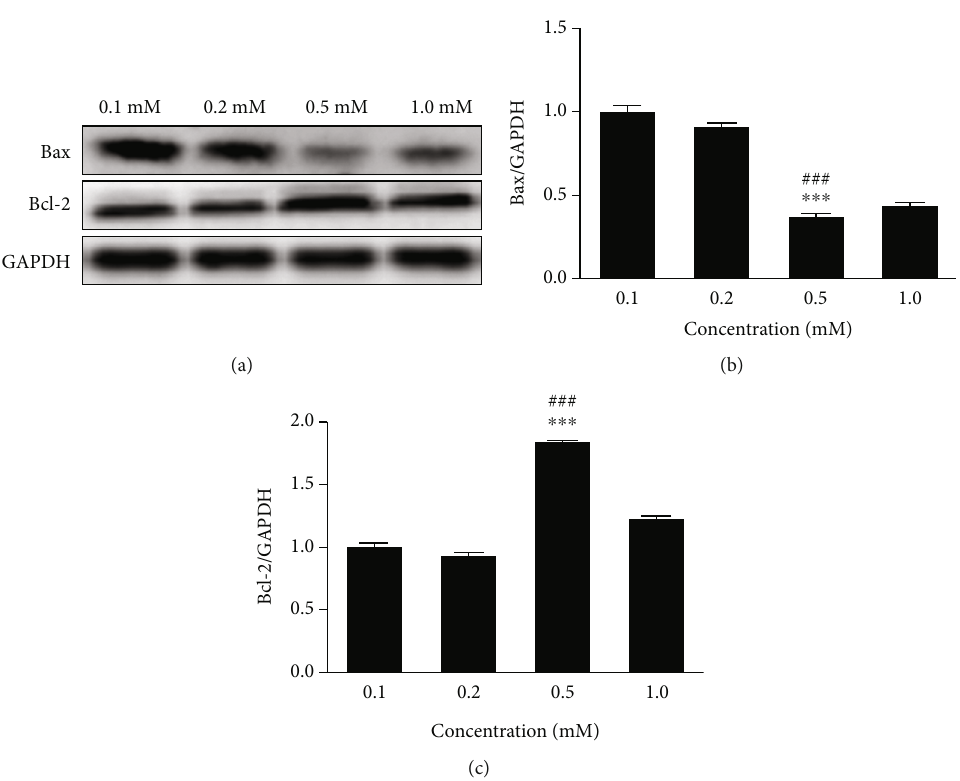
Figure 2: Neomycin-induced apoptotic protein expression with di ff erent concentrations of VC treatment. (a) Protein expression of Bax and Bcl2 was detected by Western blot in neomycin-treated HEI-OC1 cells with 0.1, 0.2, 0.5, and 1.0mM VC individually. The expression levels were normalized to GAPDH (b and c). One-way ANOVA, ∗∗∗ p < 0 : 001 versus 0.1mM group and ### p < 0 : 001 versus 1.0mM group. All tests were repeated three times independently.